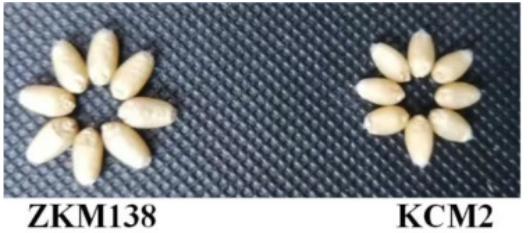
Figure 1. Grain size variation between Zhongkemai138 and Kechengmai2.